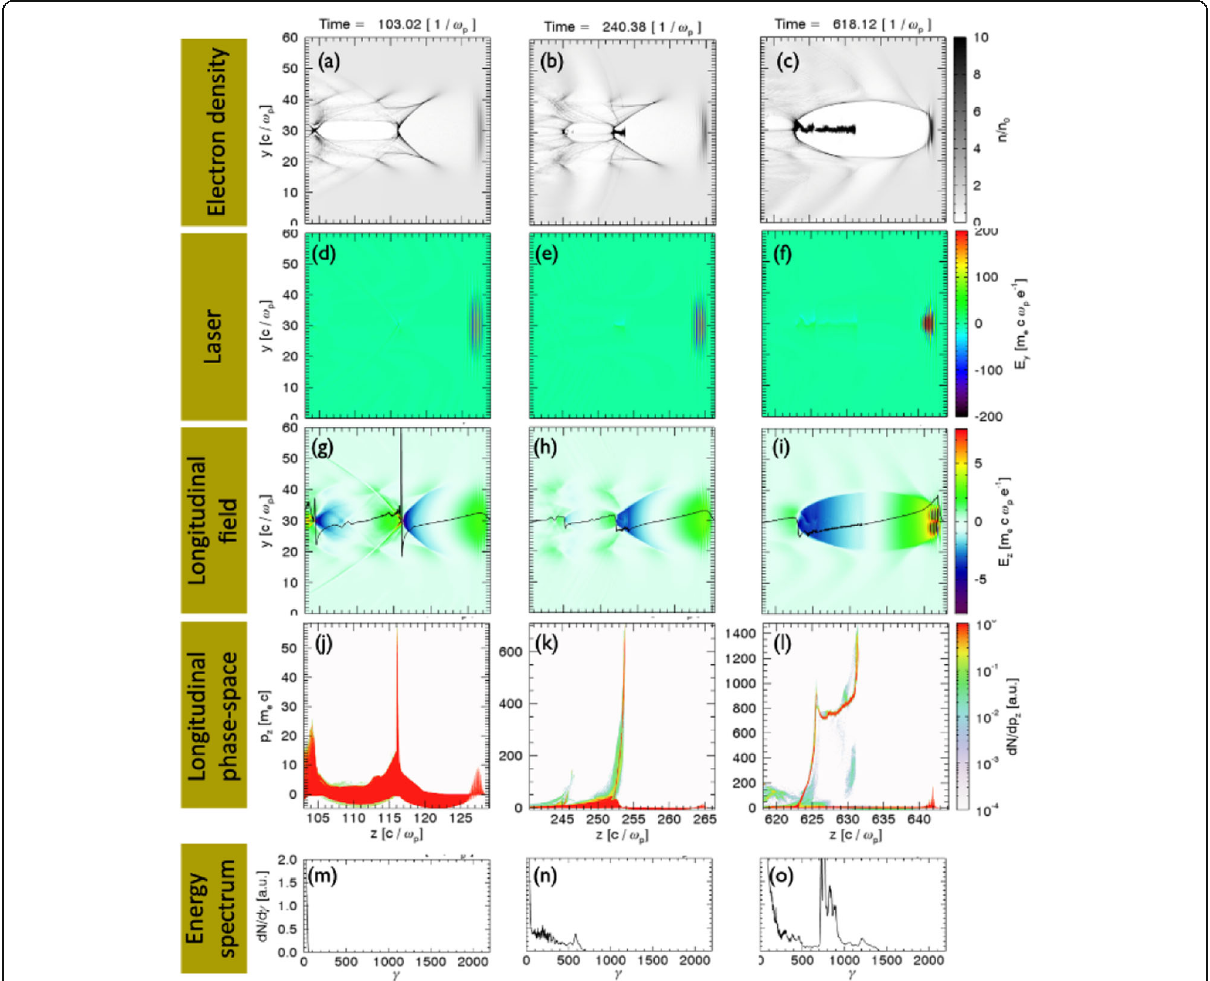
Fig. 14 Description of laser wakefield acceleration showing the evolution of wakefield excited by the laser and corresponding electron energy with c / ω p = 3 μ m (1/ ω p = 10 fs). Electron density is plotted in a , b , c ; laser electric field in d , e , f ; longitudinal electric field (and on-axis lineout) in g , h , i ; longitudinal phase-space ( z , p z ) in j , k , l ; and electron energy spectrum is plotted in m , n , and